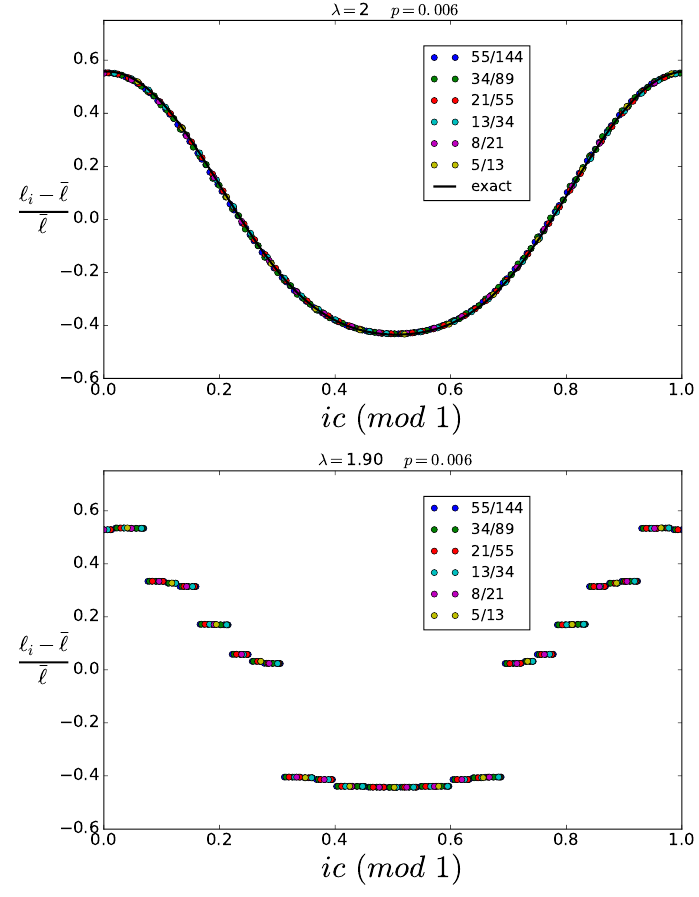
Figure 15: Envelope functions of the optimal bond lengths for the incommensurate CDW with various rational approximants. Top: integrable case ( λ = 2), continu- ous cnoidal wave. We show the exact result (solid line) from Eq. (134). Bottom: nonintegrable case ( λ = 1.9), discontinuous envelope. Here p = 0.006, ξ = 2. bond (and reduce the second